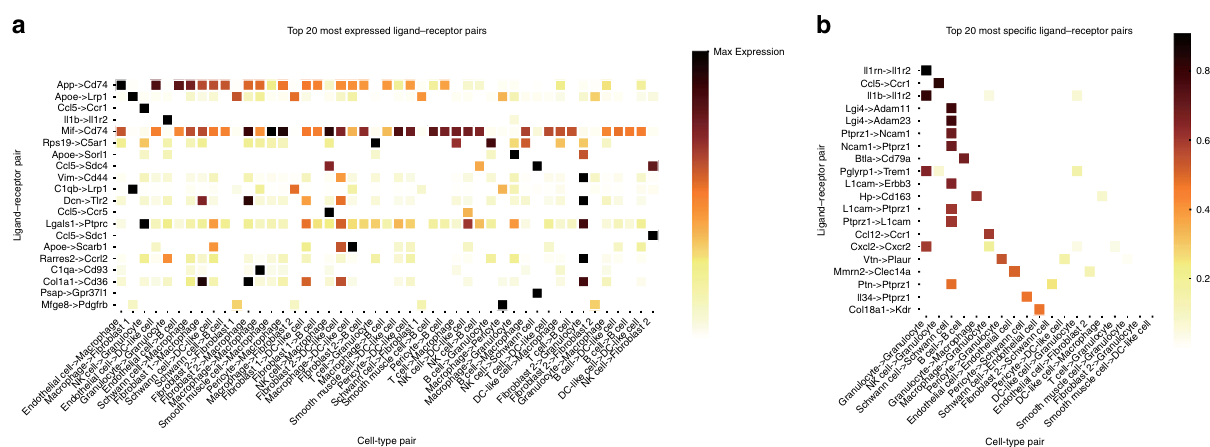
Fig. 1 Top 20 ligand – receptor pairs ranked by expression or speci fi city weighting in the Skelly et al. 11 dataset. Ligand-receptor pairs ranked by a expression (product of mean ligand expression level × mean receptor expression level). Rows are scaled by max. b Speci fi city (product of ligand speci fi city × receptor speci fi city). Ligand – receptor pairs with high expression weights ( a ) may be broadly used by many cell-type pairs, while those with high speci fi city weights ( b ) tend to be limited to one or only a few cell-type pairs. a